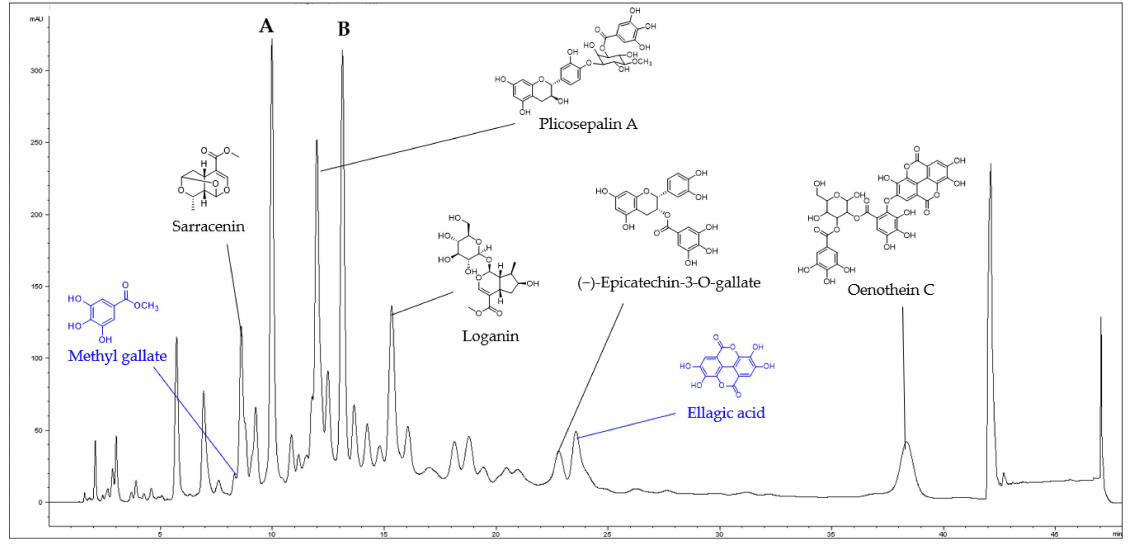
Figure 1. LC-MS fingerprint of the CO (detected at 254 nm). Methyl gallate ( t R = 8.3 min), sarracenin ( t R = 8.6 min), plicosepalin A ( t R = 12.0 min), loganin ( t R = 15.1 min), ( − )-epicatechin-3- O -gallate ( t R = 22.8 min), ellagic acid ( t R = 23.5 min), and oenothein C ( t R = 38.4 min), A and B (not